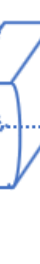
Table 2. Test results under different impact conditions.